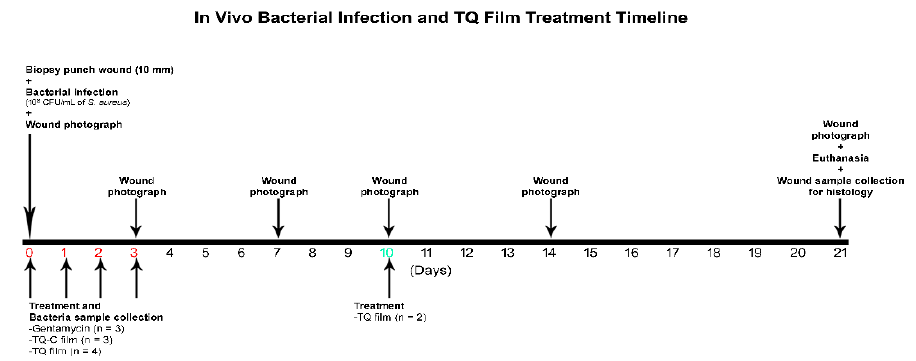
Figure 1. Flow chart depicting the experimental design for in-vivo evaluation of TQ film in a mouse model of bacterial infection. The number of mice used in each experimental group and the timeline for treatment. The time of treatment and sample collection of bacteria (red letters) is shown for each group (green letter indicates on TQ film treatment on day 10).